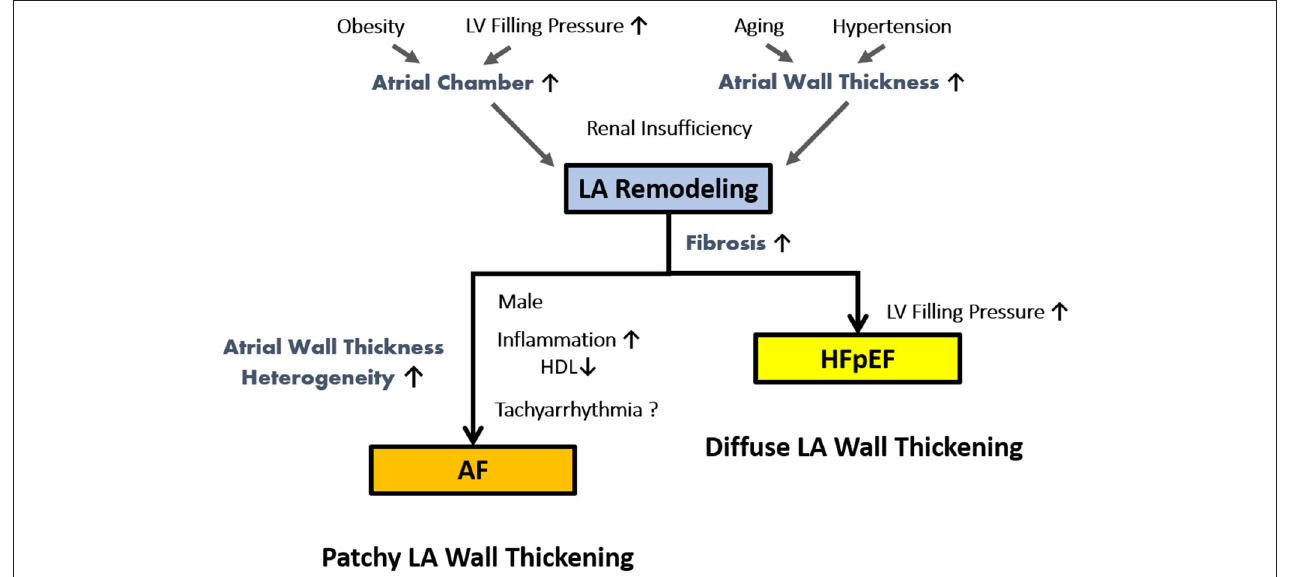
FIGURE 4 | Hypothetical distinctive pathological mechanisms of LA remodeling in AF and